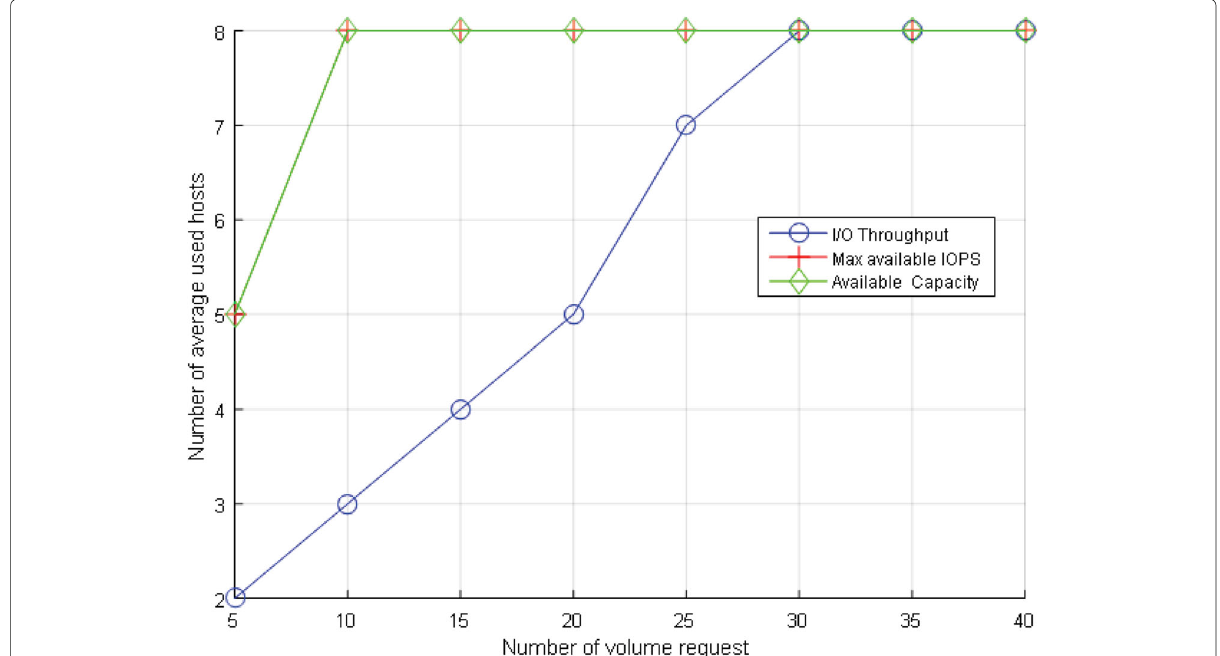
Fig. 7 Number of average used hosts of different weight sorting algorithm with different counts of